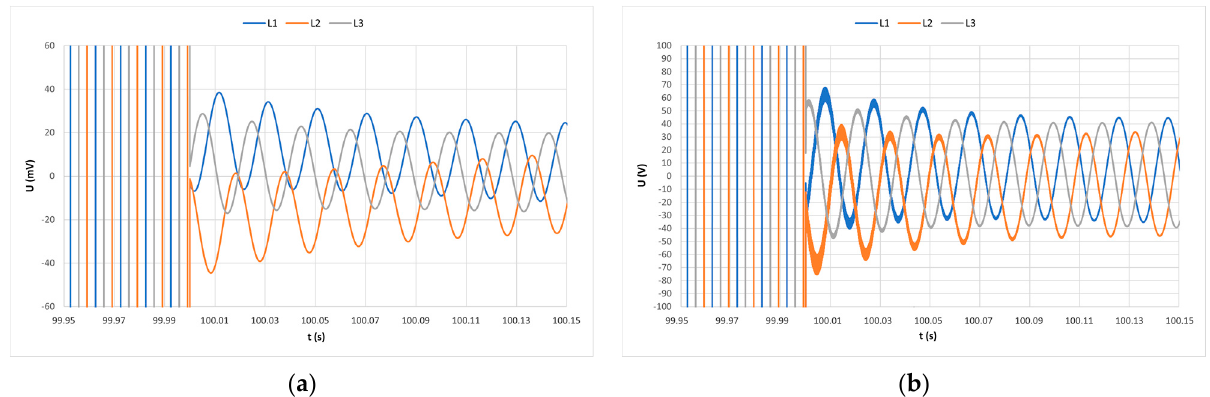
Figure 24. Simulated values of thermal power plant model voltages during a 3-Ph ground fault condition at: ( a ) the source; ( b ) the end of transmission line.